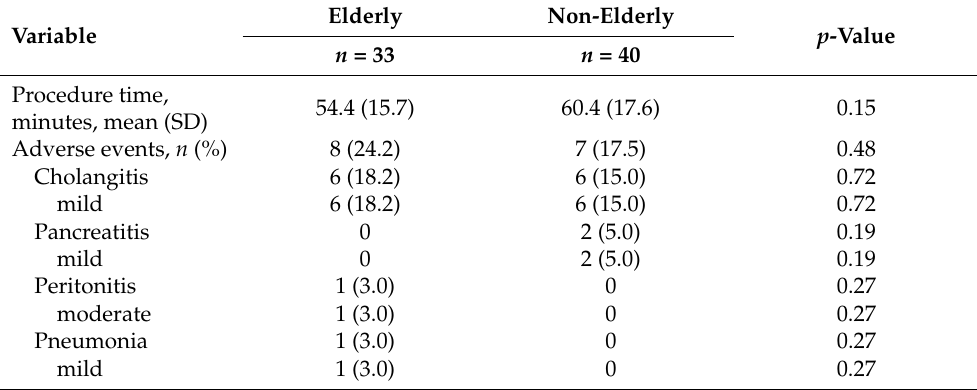
Table 4. Clinical outcomes per electrohydraulic lithotripsy